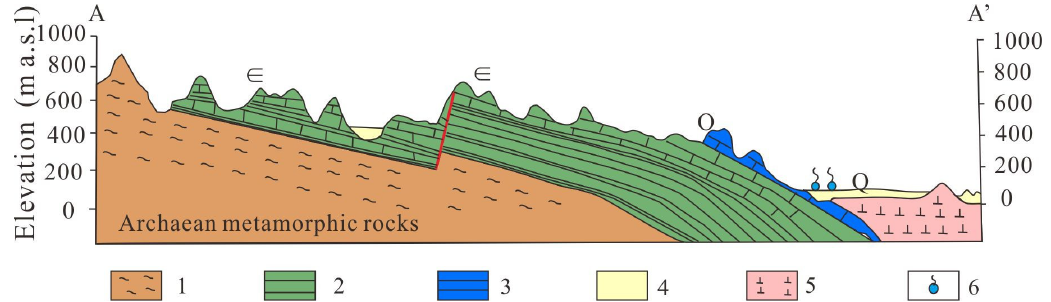
Figure 2. The geological cross map of the Jinan karst spring system. (1. Archaean metamorphic rocks; 2. Cambrian limestone; 3. Ordovician limestone; 4. Quaternary sediments; 5. Magmatic rocks; and 6. Spring).